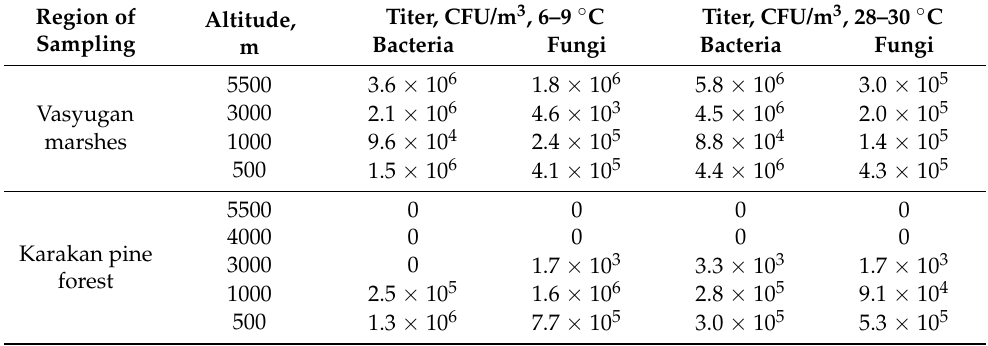
Table 3. The ratio of the number of culturable bacteria and fungi isolated from the studied aerosols. Region